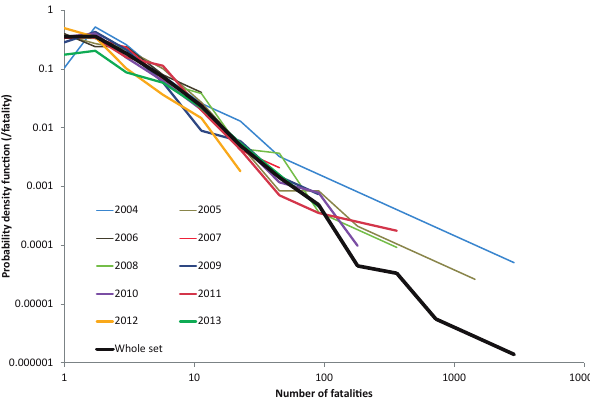
Figure 4. Annual and total probability density functions of fatal FIGURE 4 landslides for Latin America and the Caribbean.